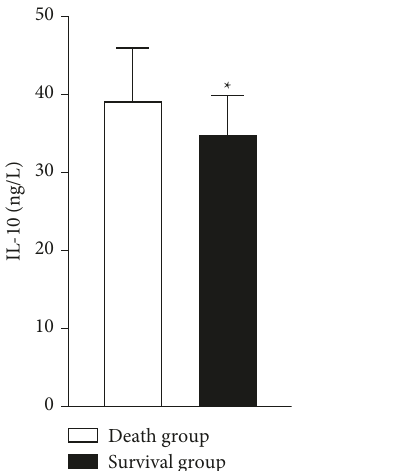
Figure 2: Distribution of IL-10 in survival group and death group.